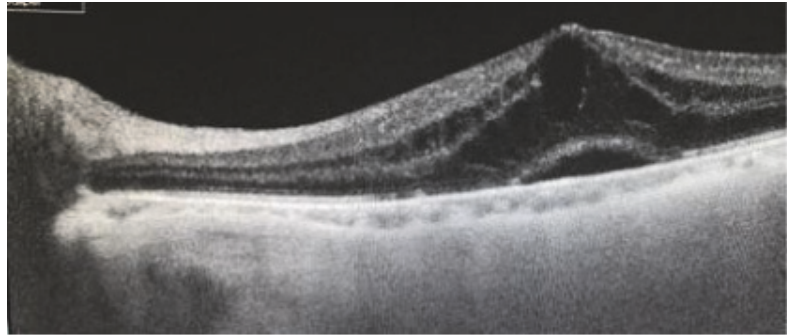
Figure 5: Cystoid macular edema with RPE detachment in one patient postoperatively.